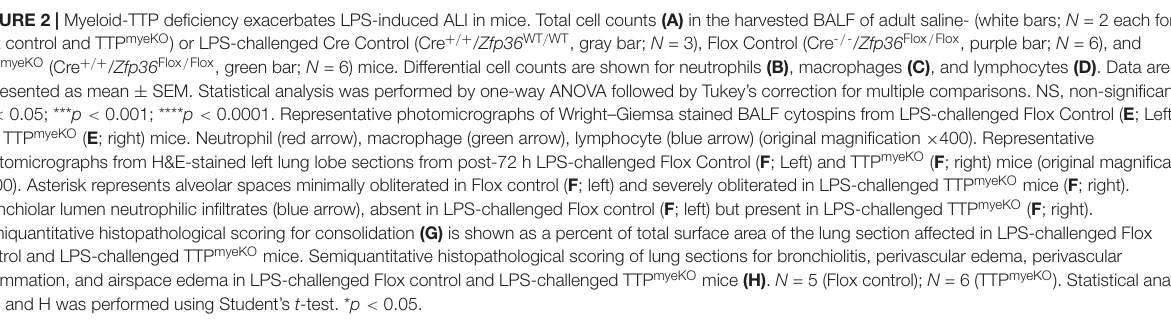
FIGURE 2 | Myeloid-TTP deficiency exacerbates LPS-induced ALI in mice. Total cell counts (A) in the harvested BALF of adult saline- (white bars; N = 2 each for Flox control and TTP myeKO ) or LPS-challenged Cre Control (Cre + / + / Zfp36 WT / WT , gray bar; N = 3), Flox Control (Cre - / - / Zfp36 Flox / Flox , purple bar; N = 6), and TTP myeKO (Cre + / + / Zfp36 Flox / Flox , green bar; N = 6) mice. Differential cell counts are shown for neutrophils (B) , macrophages (C) , and lymphocytes (D) . Data are represented as mean ± SEM. Statistical analysis was performed by one-way ANOVA followed by Tukey’s correction for multiple comparisons. NS, non-significant; * p < 0.05; *** p < 0.001; **** p < 0.0001. Representative photomicrographs of Wright–Giemsa stained BALF cytospins from LPS-challenged Flox Control ( E ; Left) and TTP myeKO ( E ; right) mice. Neutrophil (red arrow), macrophage (green arrow), lymphocyte (blue arrow) (original magnification × 400). Representative photomicrographs from H&E-stained left lung lobe sections from post-72 h LPS-challenged Flox Control ( F ; Left) and TTP myeKO ( F ; right) mice (original magnification × 200). Asterisk represents alveolar spaces minimally obliterated in Flox control ( F ; left) and severely obliterated in LPS-challenged TTP myeKO mice ( F ; right). Bronchiolar lumen neutrophilic infiltrates (blue arrow), absent in LPS-challenged Flox control ( F ; left) but present in LPS-challenged TTP myeKO ( F ; right). Semiquantitative histopathological scoring for consolidation (G) is shown as a percent of total surface area of the lung section affected in LPS-challenged Flox control and LPS-challenged TTP myeKO mice. Semiquantitative histopathological scoring of lung sections for bronchiolitis, perivascular edema, perivascular inflammation, and airspace edema in LPS-challenged Flox control and LPS-challenged TTP myeKO mice (H) . N = 5 (Flox control); N = 6 (TTP myeKO ). Statistical analysis in G and H was performed using Student’s t -test. * p <